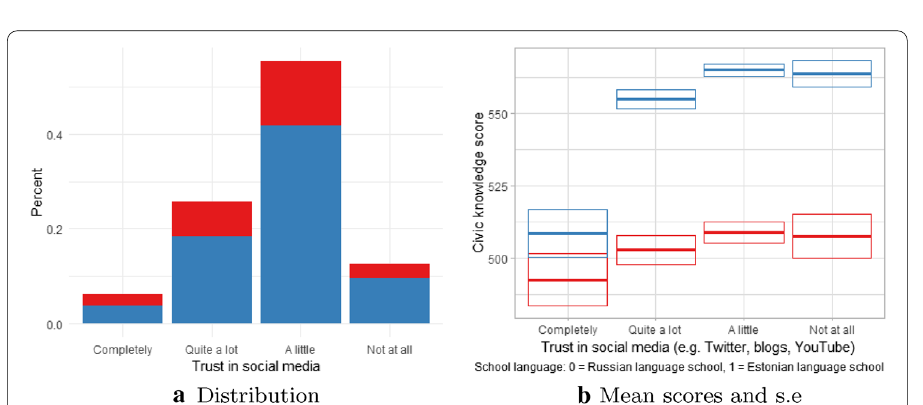
Estonian language school, red =